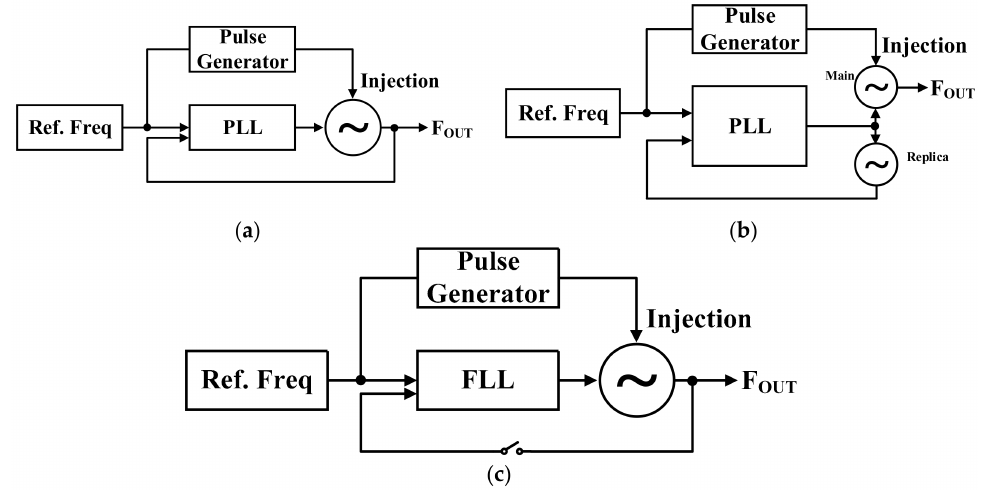
Figure 4. Structure of the ILFM ( a ) PLL based; ( b ) dual-loop PLL based; and ( c ) the proposed open-loop ILFM structure using